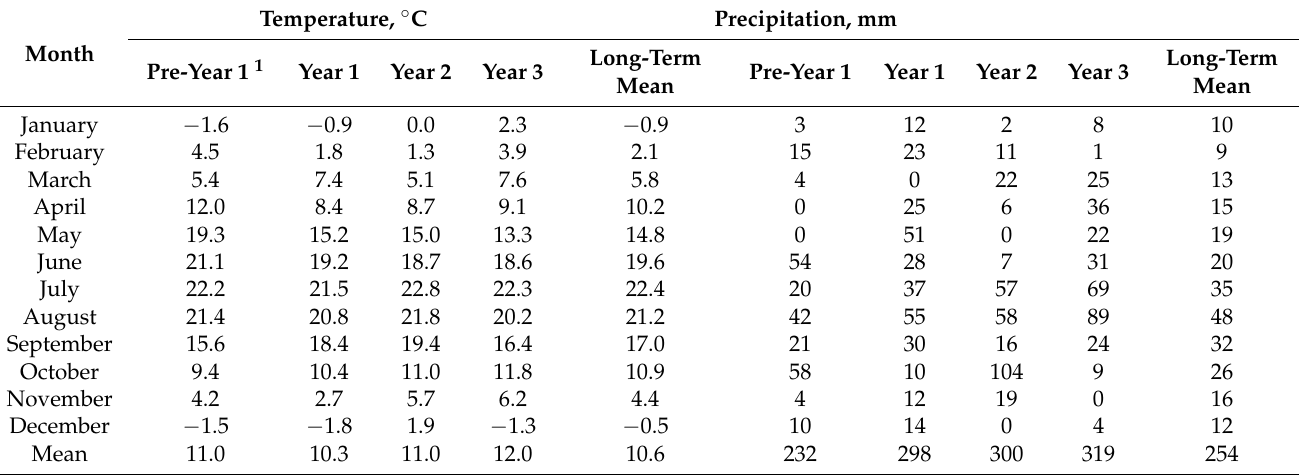
Table 1. Monthly mean air temperatures and total precipitation at Alcalde, New Mexico, USA, from each year of the study period and the long-term (1953–2016)